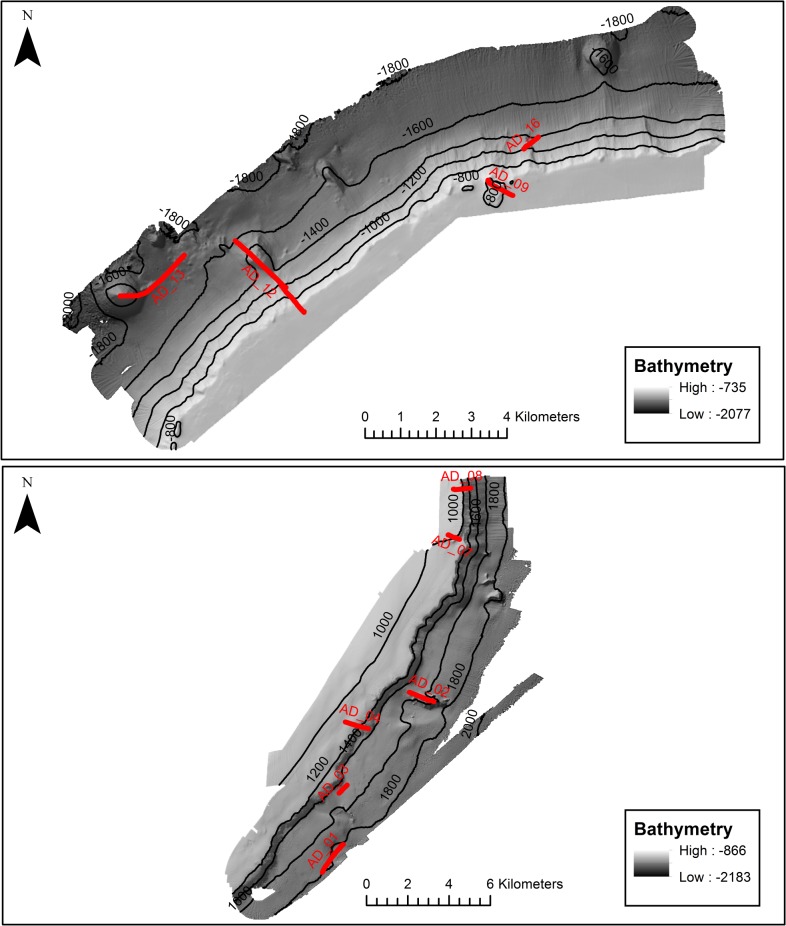
Camera transects sampled from the NW (top) and SE (bottom) survey areas of Anton Dohrn Seamount overlaid on multibeam bathymetry.Selected bathymetric contours are shown as dashed lines with labelled water depths in metres below sea level.